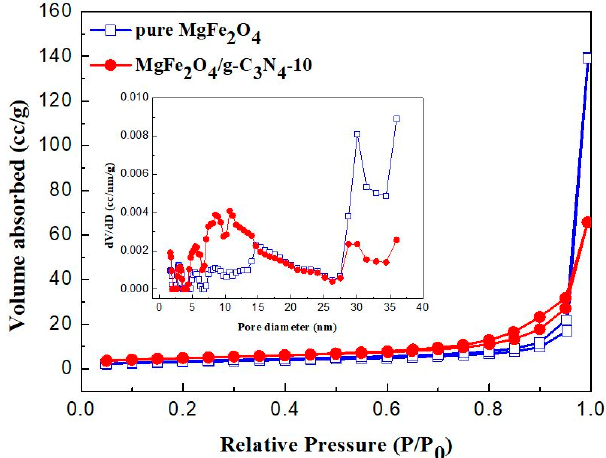
Figure 5. N 2 adsorption–desorption isotherms and (inset) the corresponding pore size distribution curves of the MgFe 2 O 4 porous microspheres and MgFe 2 O 4 /g-C 3 N 4 -10 composites.